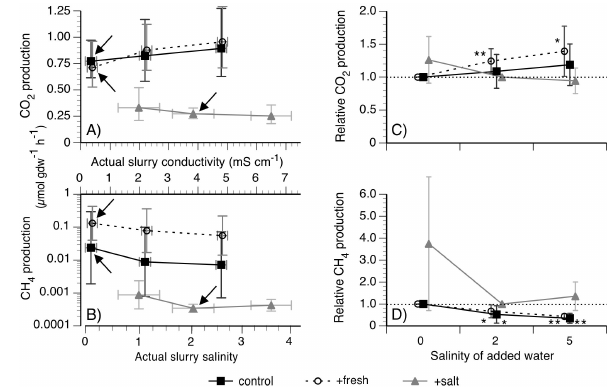
Fig. 2. Short-term effects of elevated salinity on rates of CO 2 and CH 4 production. (A, B) Absolute rates of CO 2 and CH 4 produc- tion as a function of the salinity of the soil slurry. (C, D) Rates of CO 2 and CH 4 production relative to gas production at field salin- ities (salinity = 0 for control and + fresh soils, 2 for + salt soils). Due to porewater already present in the soil, the final salinity of the slurries was somewhat different from that of the added water (see the x axis on panels (A) and (B) for actual slurry salinities). On panels (A) and (B) , the data points highlighted with arrows are the same data shown for the 3–8cm depth interval on Fig. 1 (i.e., rates at field salinities). On panels (C) and (D) , asterisks indicate that the relative CO 2 or CH 4 production was significantly different than 1.0 ( ∗ : p ≤ 0 . 10; ∗∗ : p ≤ 0 . 05). Values are means ± standard deviation, n = 5 plots per data